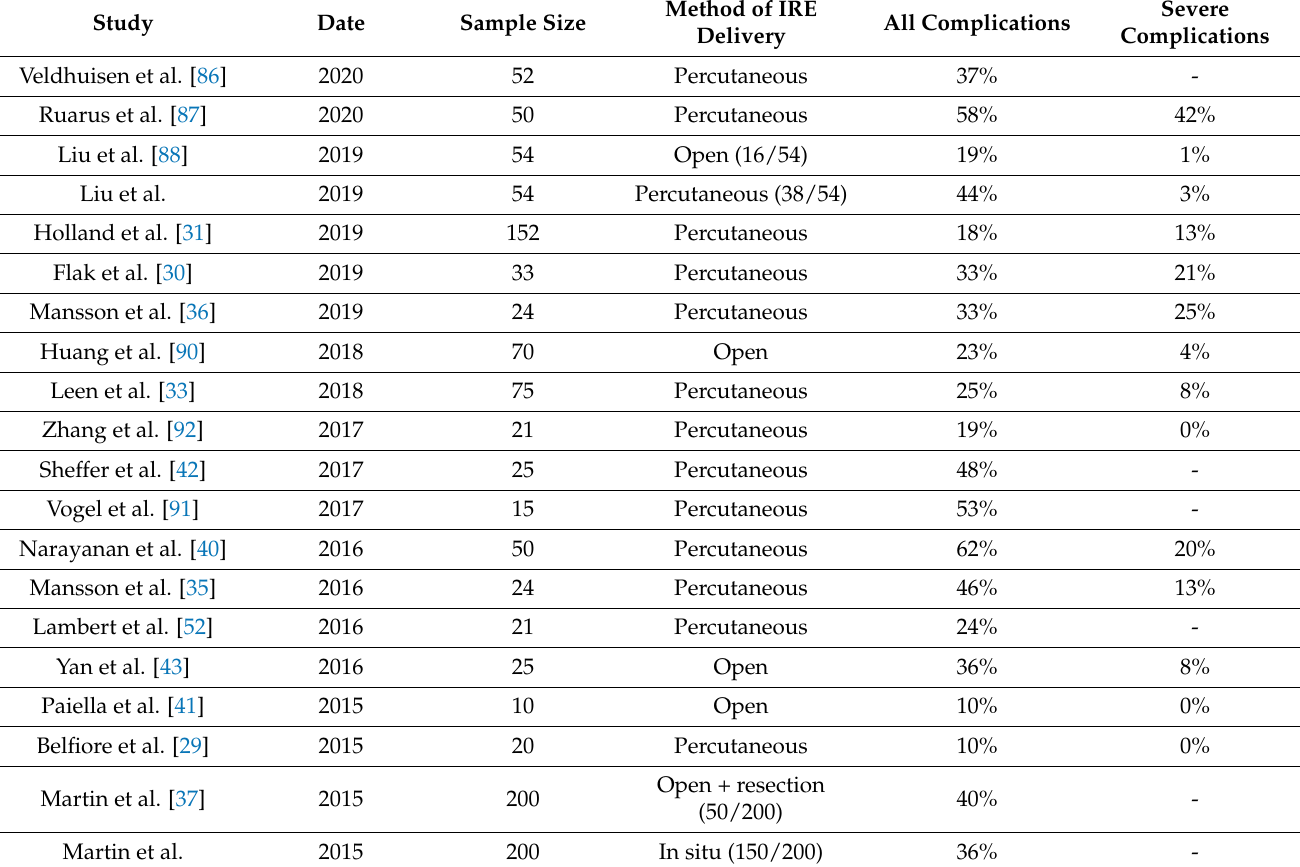
Table 2. Incidence and severity of complications reported in clinical studies of IRE treatment for pancreas